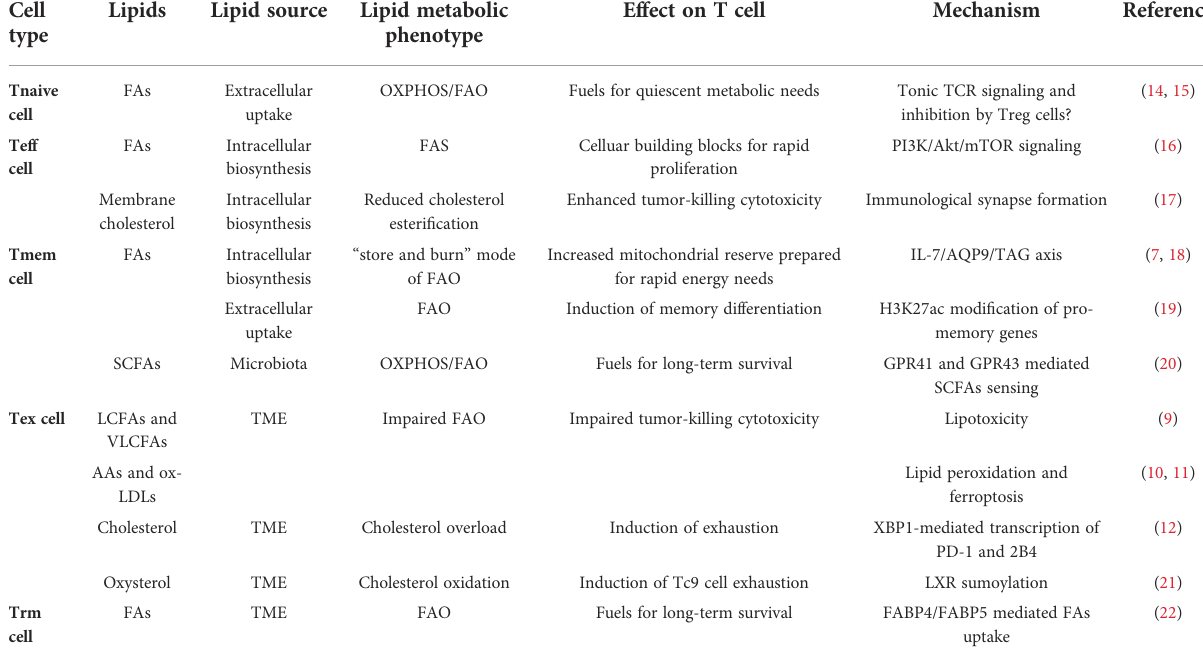
TABLE 1 lipids/lipid metabolites and lipid metabolism pro fi le in CD8 + T cell